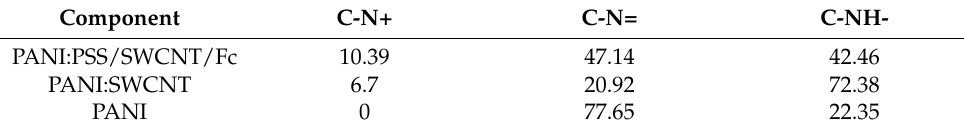
Table 4. The component for Fe